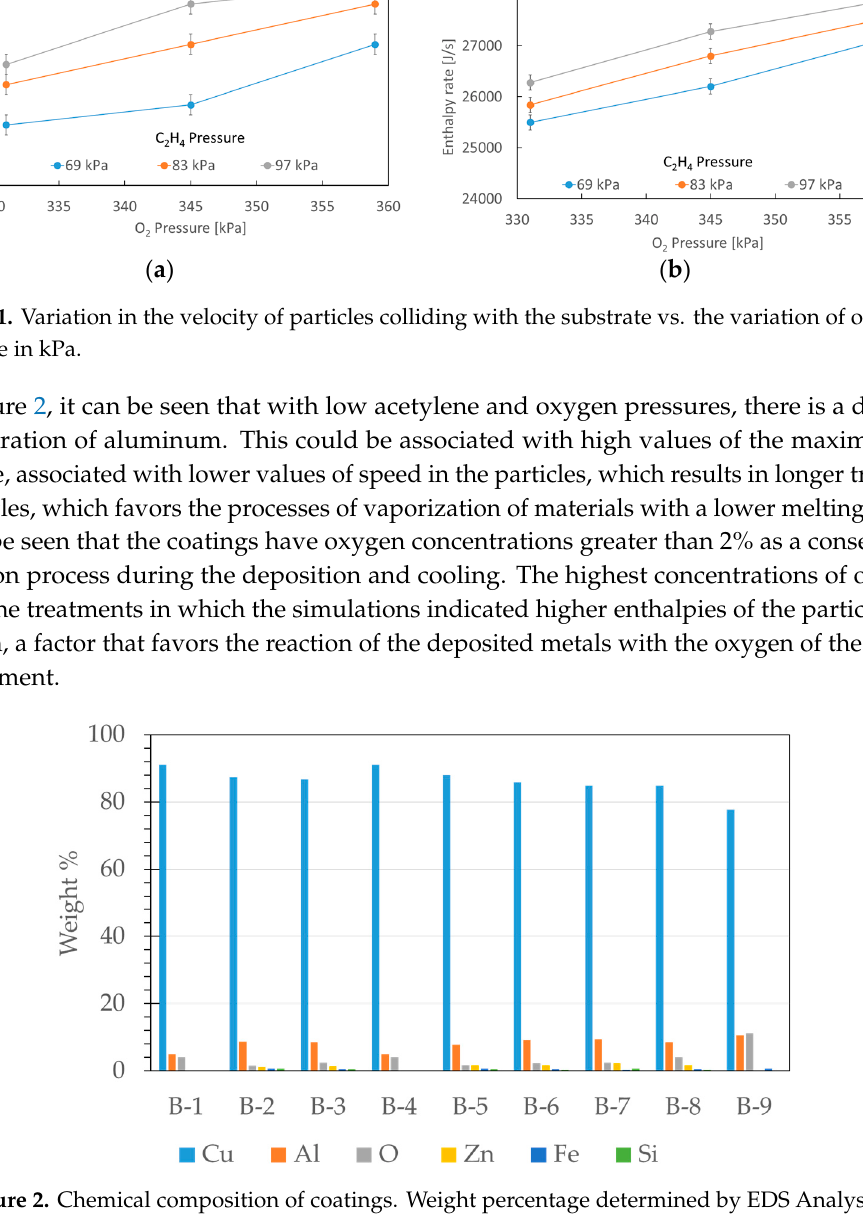
Figure 1. Variation in the velocity of particles colliding with the substrate vs. the variation of oxygen pressure in kPa.